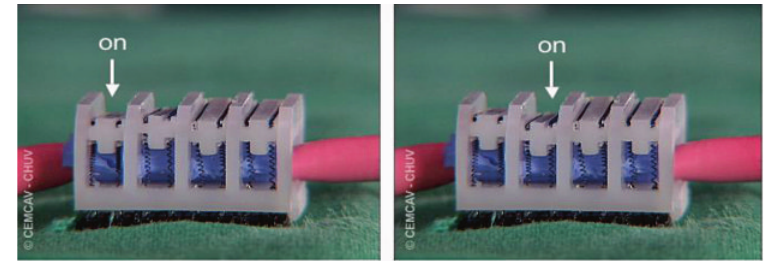
The ‘piano’ effect permits recovery of the urethral tissue segments.The modules alter- nately act in open and closed positions with a pre-defined time sequence. In stress situations more than one module can switch to the closed stage to increase the resist- ance of the device to the pressure pulses.